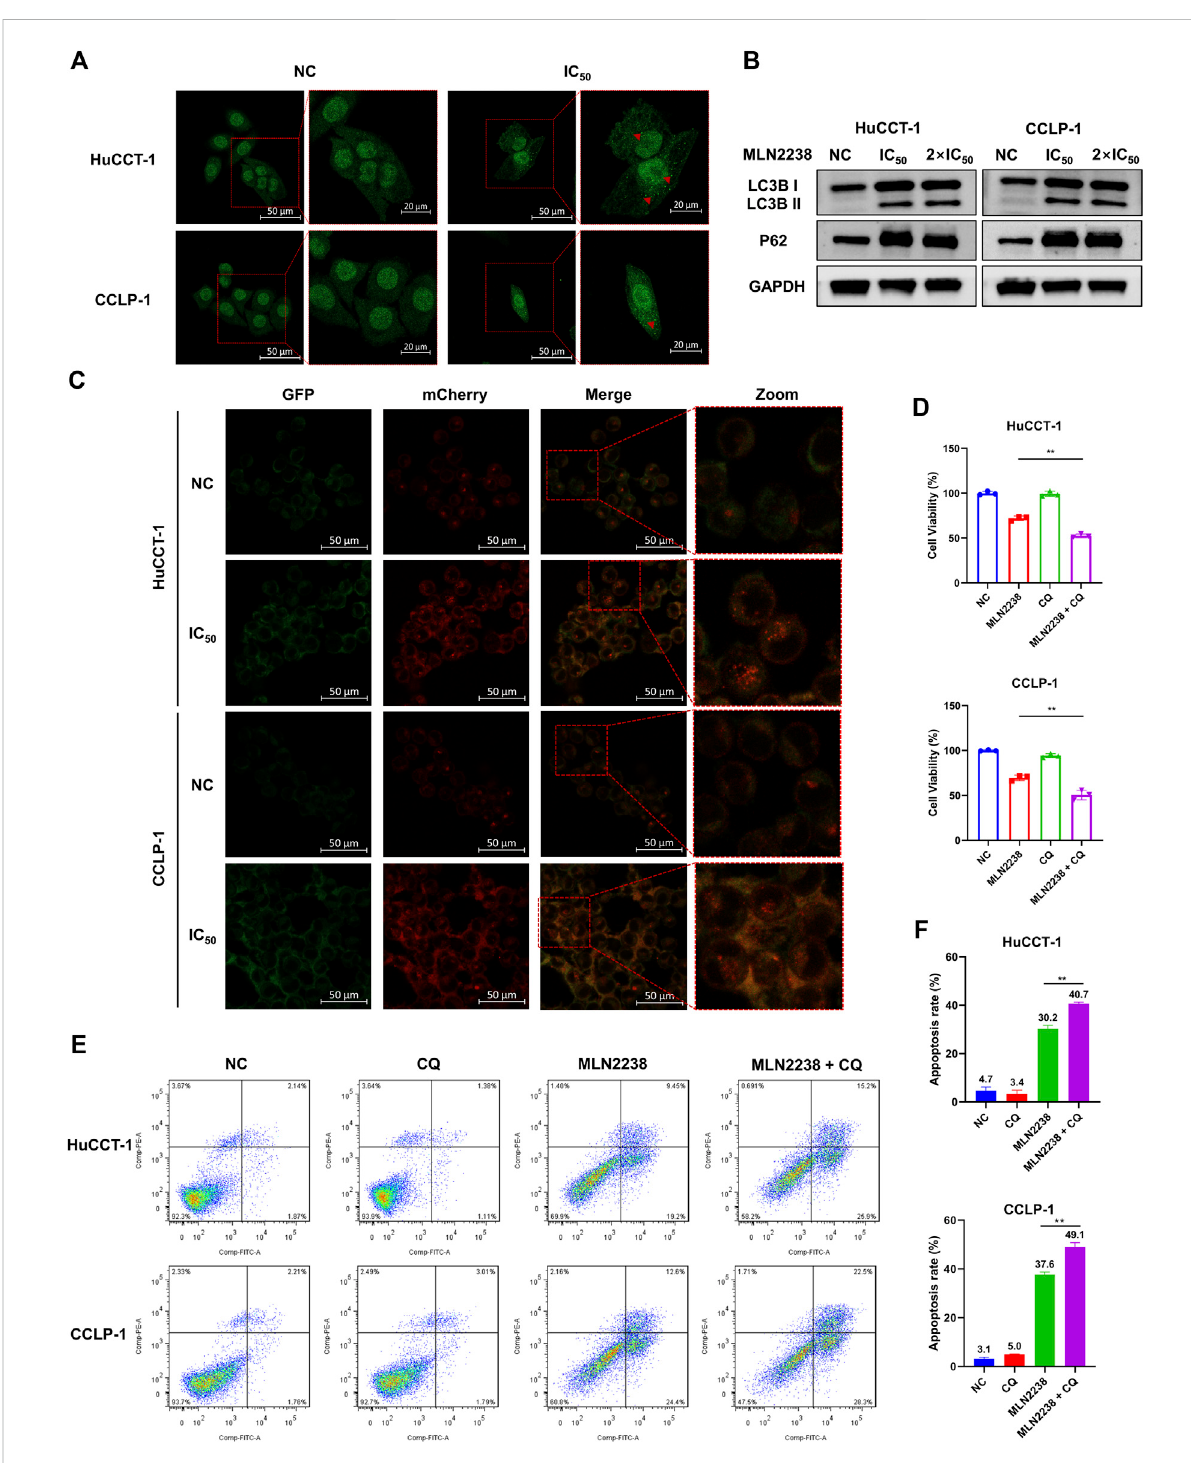
FIGURE 5 MLN2238 induced the autophagy in HuCCT-1 and CCLP-1 cells. (A) Autophagy induction was observed by immuno fl uorescence microscopy after MLN2238 treatment for 24 h (Red arrows points to LC3B puncta). (B) The protein expression levels of LC3B and P62 after treatment with IC50 and 2×IC50 concentration of MLN2238 were analyzed via Western Blots. (C) Ad-mCherry-GFP-LC3 was used to estimate the autophagy fl ux after MLN2238 treatment in iCCA cells. (D) Cell counting kit-8 analysis and (E) fl ow cytometry analysis was performed to evaluated the cell viability after treatment with MLN2238 and autophagic inhibitor (chloroquine). (F) The quantitative apoptosis rates of HuCCT-1 and CCLP-1 cells are presented via